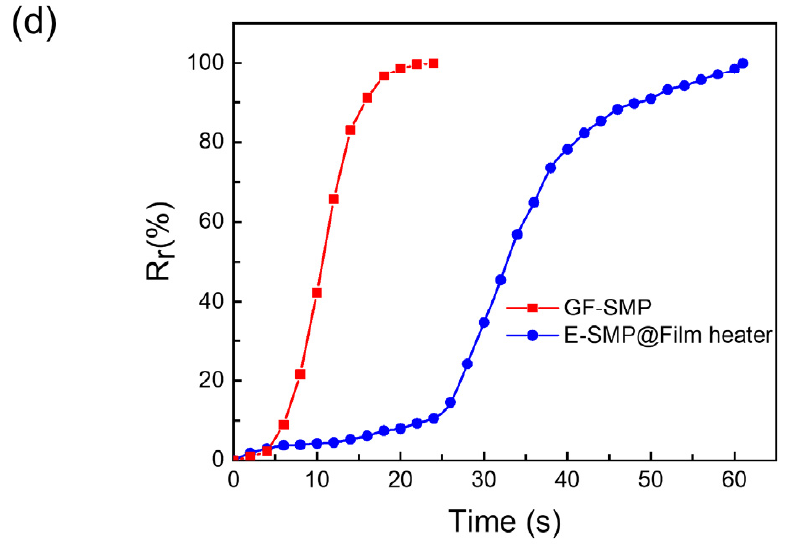
Figure 5. Comparison of shape memory properties of GF-SMP and E-SMP samples. ( a ) Photographs of an E-SMP sample with a thin film heater wrapped underneath (E-SMP@Film-heater, left) and a GF-SMP sample (right), ( b ) Shape memory model, ( c ) Electro-triggered shape recovery process of the E-SMP@Film-heater and the GF-SMP sample (inset: a side view photo to show the electrode and the wire), ( d ) Time dependent shape recovery rate for the E-SMP@Film heater and GF-SMP sample.